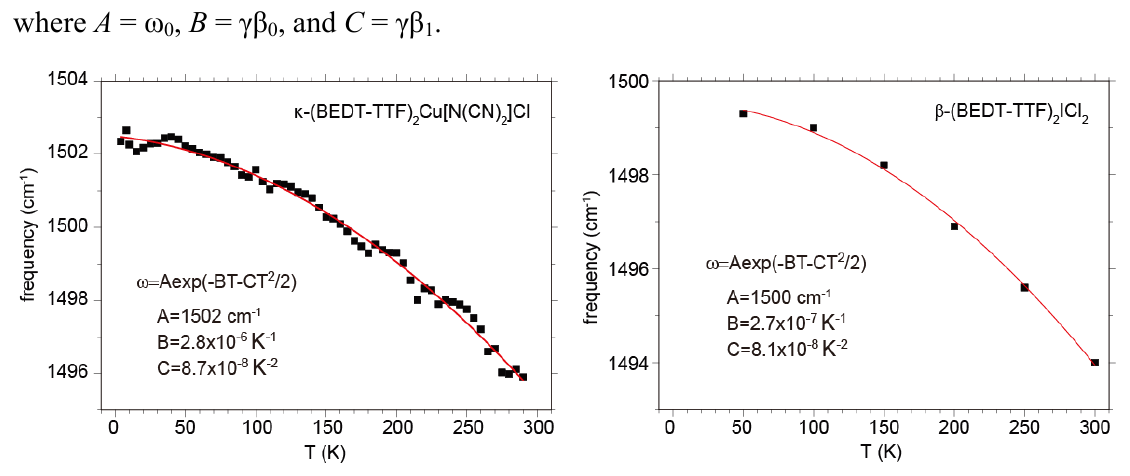
Figure 22. Temperature dependence of the frequency of ν and β′ -(BEDT-TTF) where A = ω